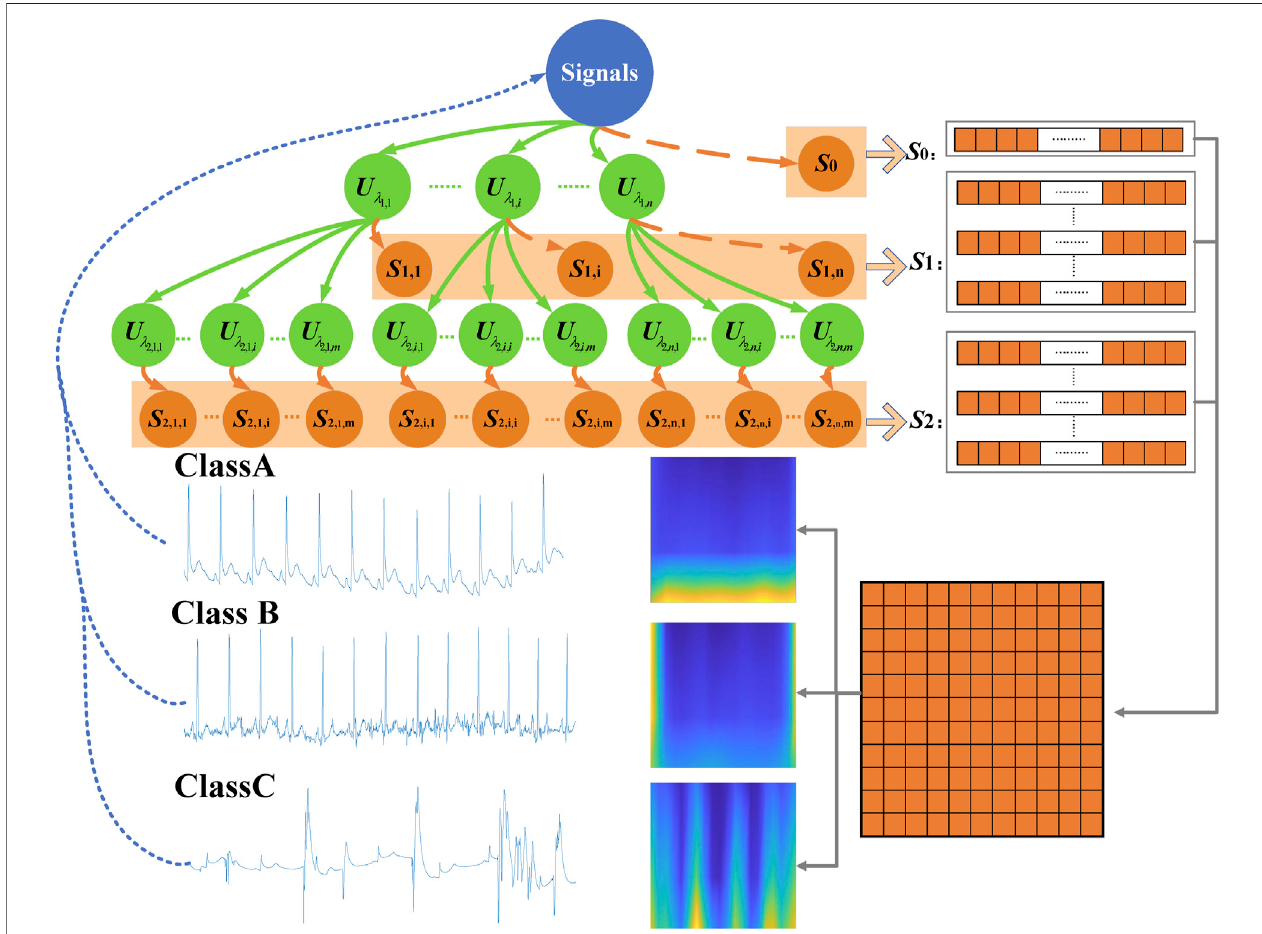
FIGURE 3 | Three-layer wavelet scattering